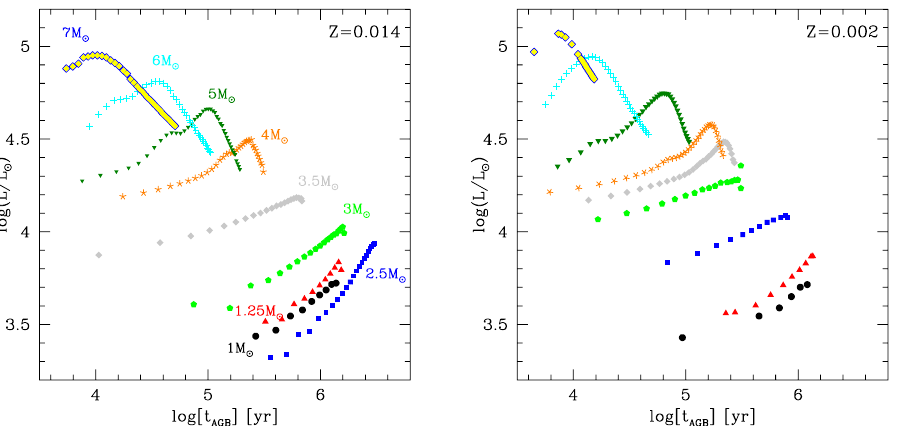
Figure 3. ( Left ) Time variation of the luminosity of solar metallicity model stars during the AGB phase. Each point corresponds to an inter-pulse phase. The numbers near the different tracks and symbols indicate the initial mass of the star. Times are counted from the beginning of the AGB phase. ( Right ) Same as the left panel, but for the Z = 2 × 10 − 3 metallicity. The same correspondence between the symbols and the initial mass of the star was